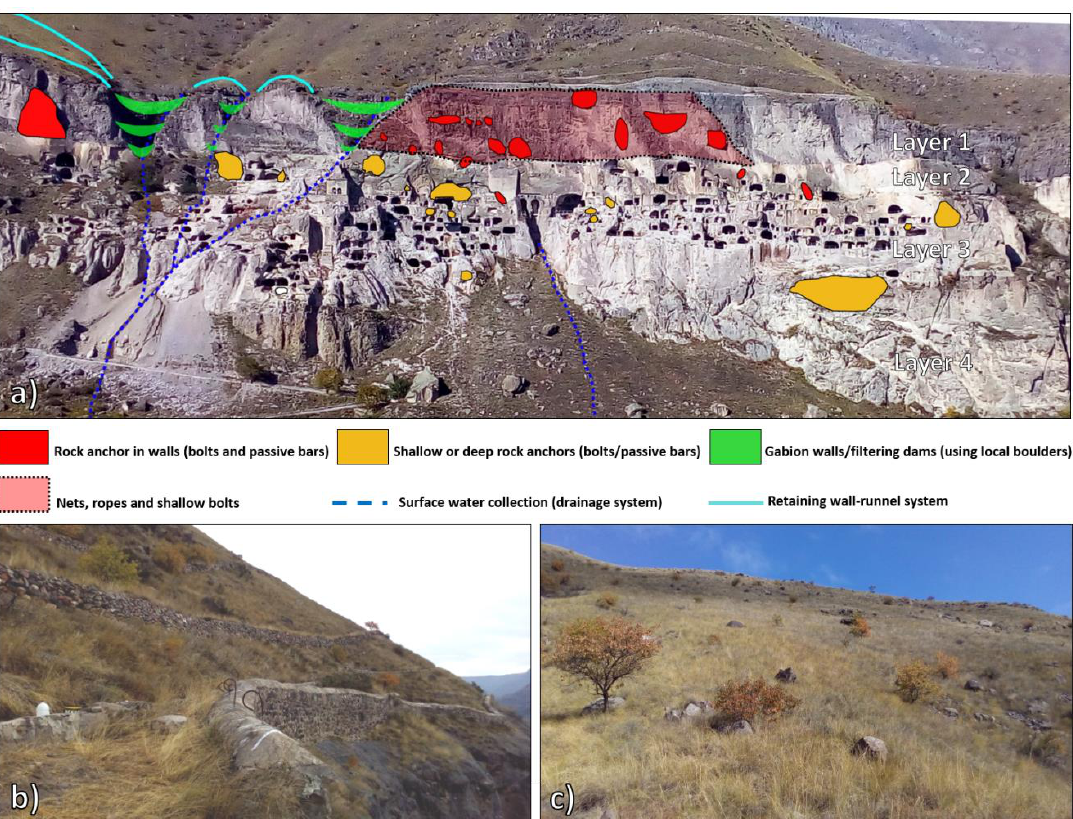
Figure 16. a ) Contribution to the General Master Plan of the proposed mitigation measures for the whole Vardzia Monastery: system of surface water collection and runnel-retaining walls built along the monastery slope rock wall upper sector (modified after [17]), sectors characterized by instability on the rock cliff with related anchor type, b ) Water draining structures in Vardzia formed by the runnel-retaining wall system, c ) detail of scattered boulder of the upper slope sector.